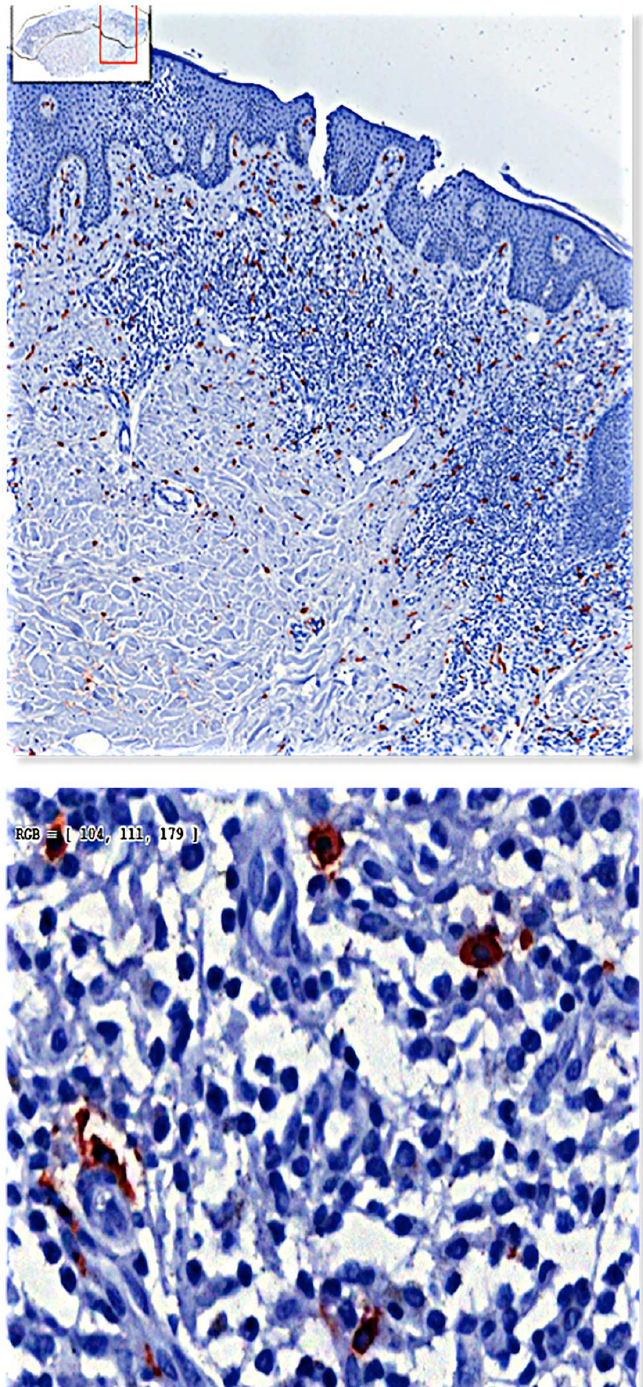
Figs 1a and b. Immunohistochemistry staining with a monoclonal anti-mast cell tryptase antibody.